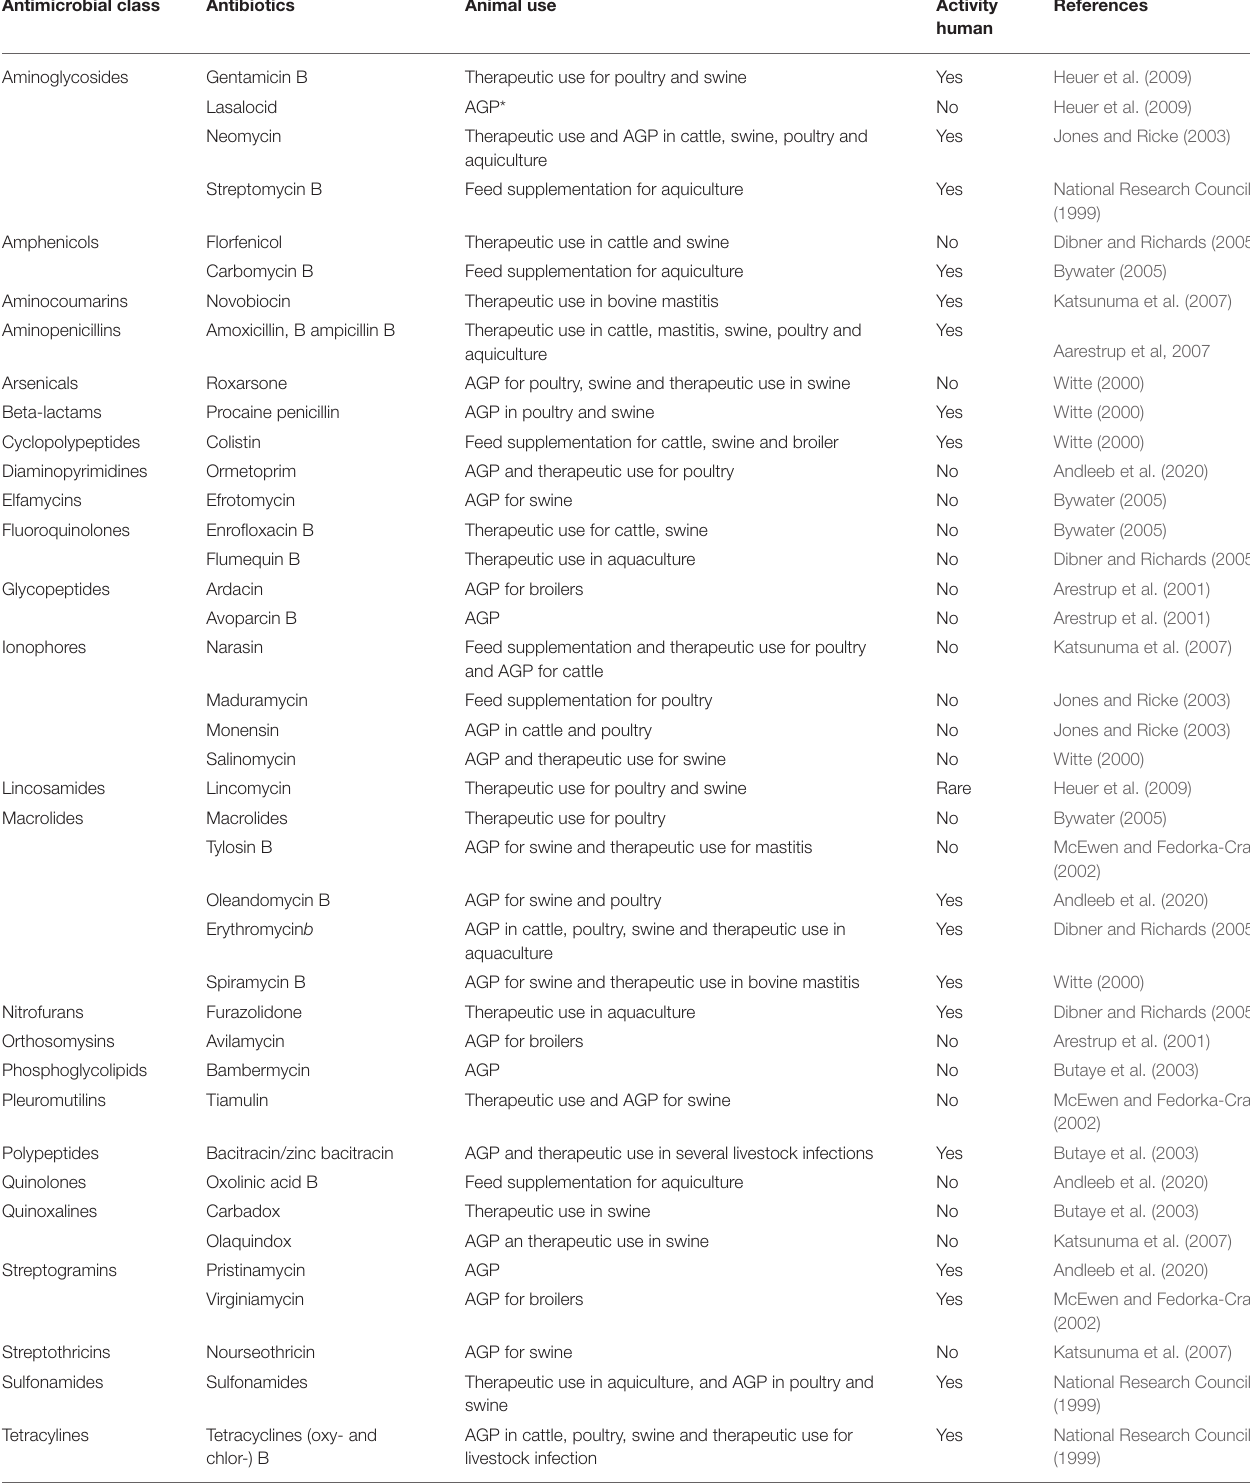
TABLE 1 | Antimicrobial agents used in animals and humans. Antimicrobial